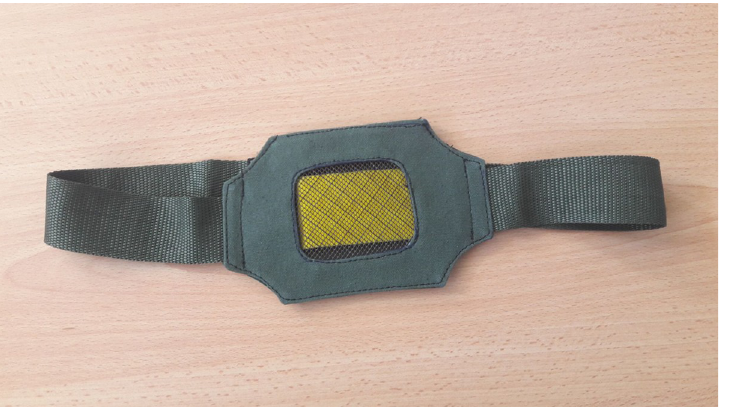
Fig 1. Tsetse fly WRB